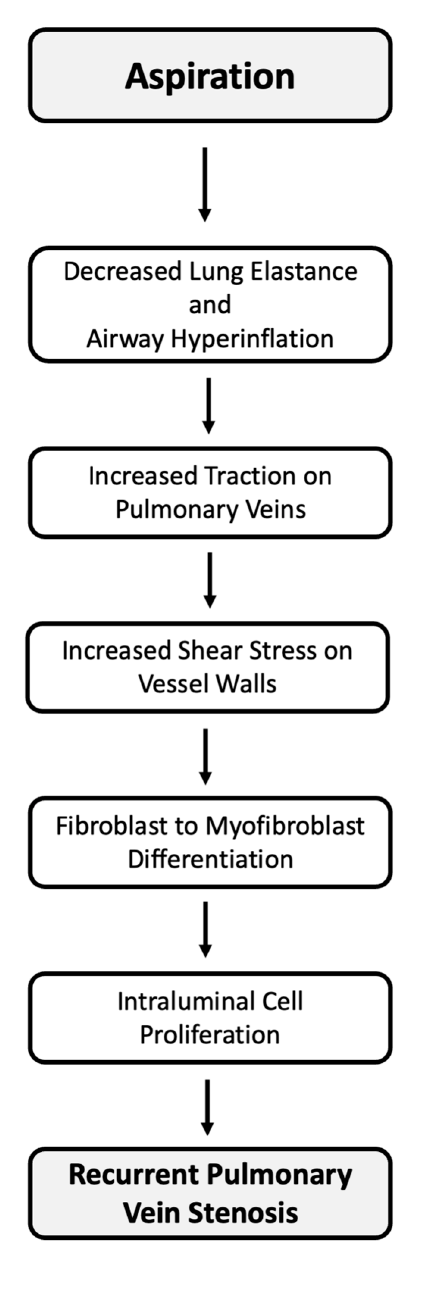
Figure 1 . Proposed Mechanism of PVS Recurrence. Schematic outlining a potential mechanism by which aspiration and male sex lead to PVS recurrence. which aspiration and male sex lead to PVS